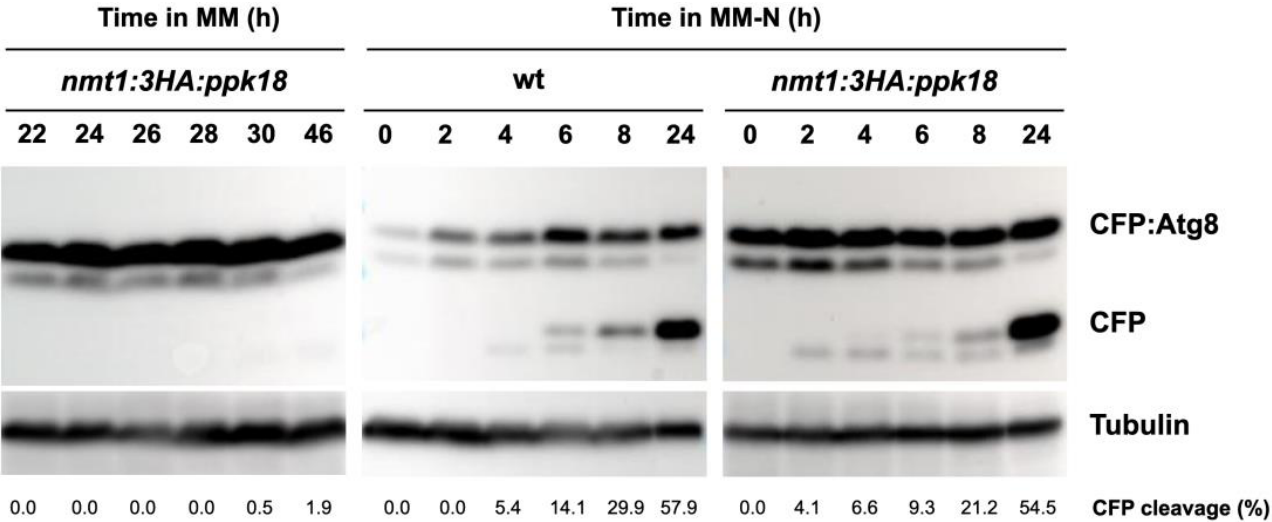
Figure 5. Greatwall overexpression is not sufficient to induce autophagy but slightly accelerates autophagic flux. Wild type and cells expressing ppk18 + under the nmt1 promoter (nmt1:3xHA:ppk18 + ) and CFP:Atg8 were grown in thiamine-containing minimal medium (MM+T, promoter OFF) at 25 °C until mid-exponential phase, and then transferred to thiamine-free minimal medium (MM-T, promoter ON) to induce ppk18 + expression. After 22 h, part of the culture (panels middle and right) was transferred to nitrogen-free minimal medium (MM-N) for 24 h at 25 °C. Samples were taken at 0, 2, 4, 6, 8, and 24 h in MM-N. CFP:Atg8 and free CFP levels were determined using anti-GFP antibodies (Chromotek). Tubulin was used as a loading control. The percentage of CFP cleavage is indicated under the gels.